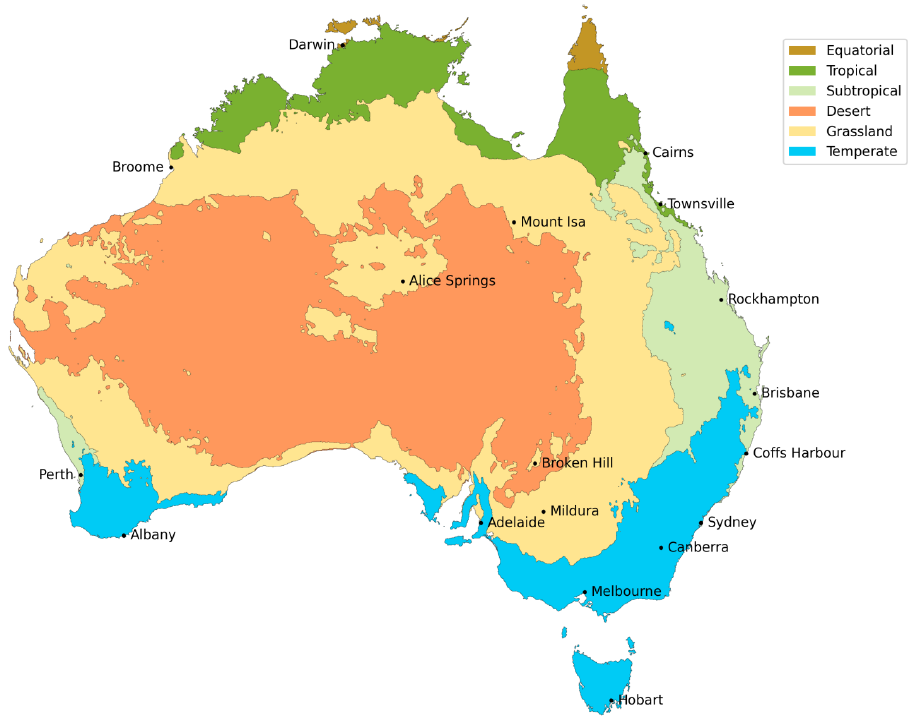
Figure 1. Koppen climate classification of Australia adapted from [45]. Copyright Commonwealth of Australia. Repro- duced under CC-BY